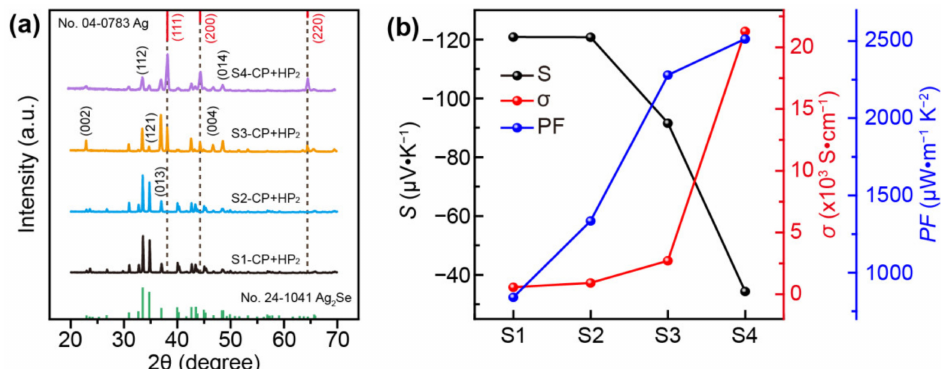
Figure 3. TE performance of Ag 2 Se/nylon films of samples 1–4 under the combination of cold-press and hot-press. ( a ) Seebeck coefficient, electrical conductivity, and power factor. ( b ) XRD patterns of the Ag 2 Se/nylon films corresponding to samples 1–4.